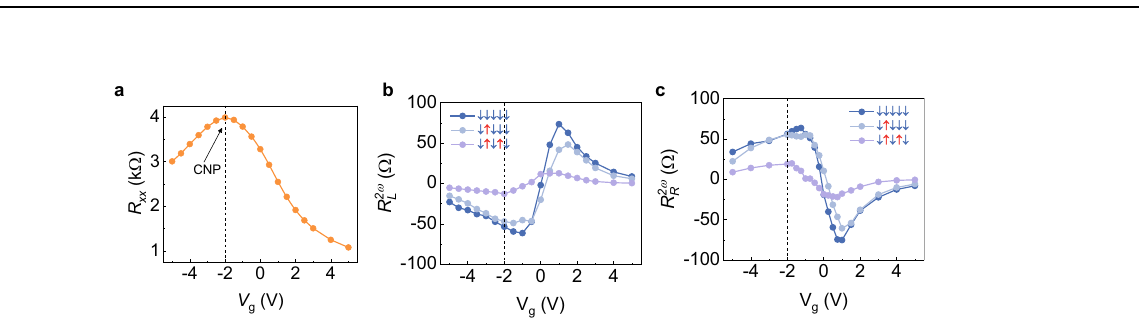
top gate voltage of − 2V. b , c Non-reciprocal resistance measured at left edge and right edge of the 5-SL MnBi 2 Te 4 , respectively. Different curves show the non- reciprocal resistance at spin states of ↓↓↓↓↓ , ↓↑↓↓↓ and ↓↑↓↑↓